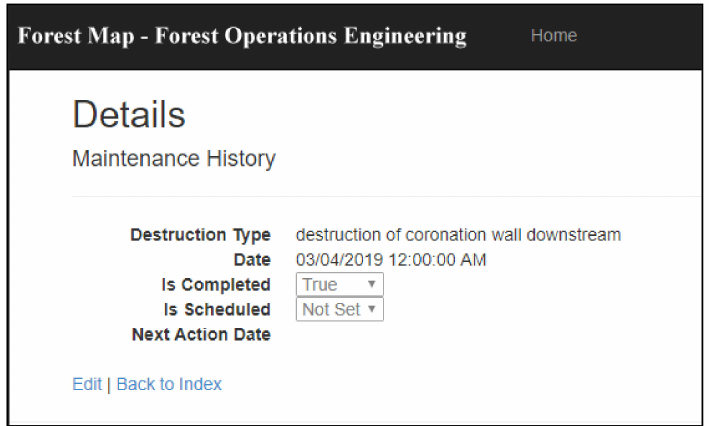
Figure 3. The “Maintenance History” display screen of the web application